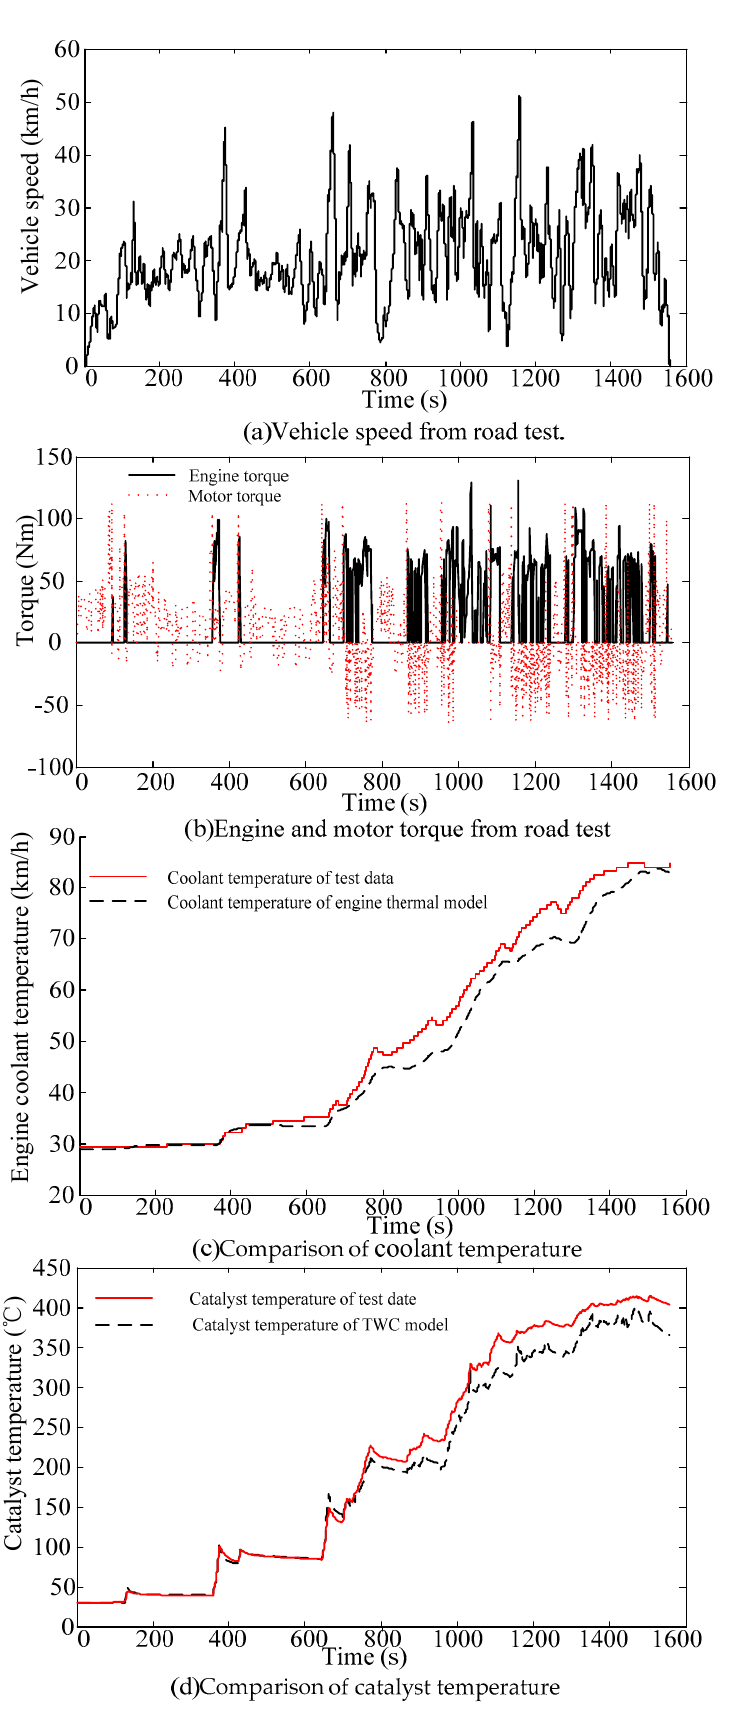
Figure 9. Parameter estimation by matching the model’s temperature response to the test data.